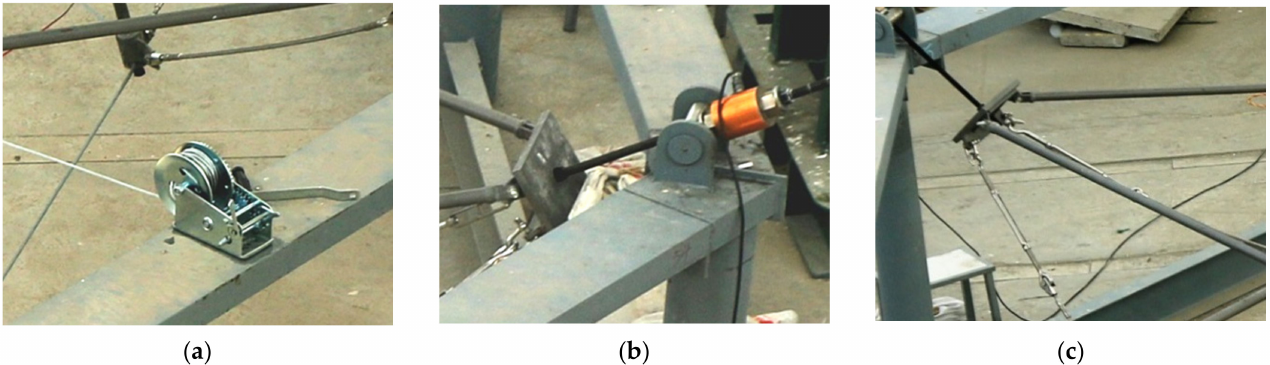
Figure 15. Toolings of the traction-lifting and tensioning technology. ( a ) Hoister; ( b ) Gusset plate; ( c ) Adjustable stainless steel 304 basket